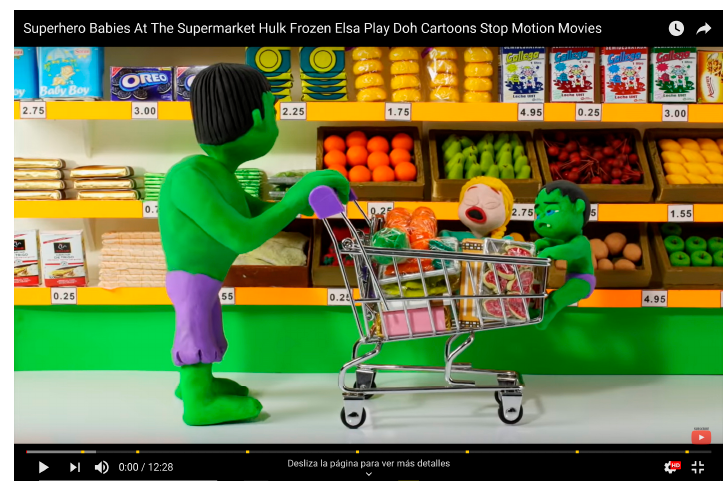
Figure 12. Superhero Babies at the Supermarket Hulk Frozen Elsa Play Doh Cartoons Stop Motion Movies . © Doggy Doggy Cartoons.